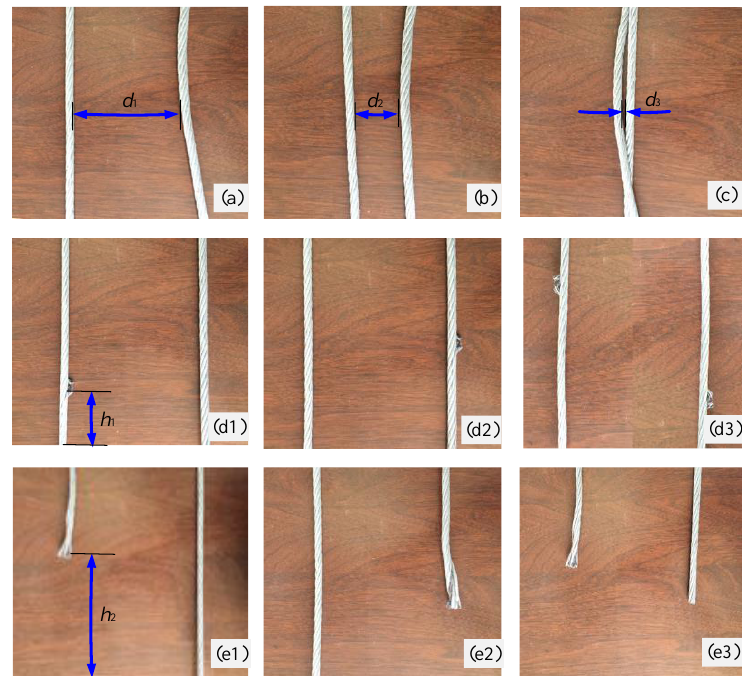
Figure 5. The nine characteristics of tail ropes. ( a ) Normal; ( b ) disproportional spacing; ( c ) twisted rope; ( d ) broken strand (( d1 ) refers to broken strand of the left rope, ( d2 ) of the right rope, and ( d3 ) of double ropes); and ( e ) broken rope (( e1 ) refers to the left broken rope, ( e2 ) refers to the right broken rope, ( e3 ) refers to the double broken ropes).